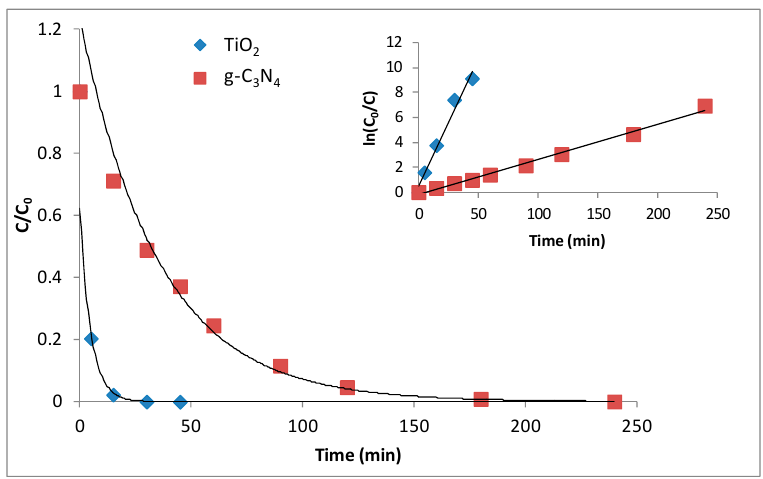
Figure 1. Photocatalytic degradation kinetics of valsartan by TiO 2 and g-C 3 N 4 catalysts ((valsartan) = 5 mg L − 1 ; (catalyst) = 100 mg L − 1 ; I = 500 Wm − 2 ). The concentrations of • OH radicals generated by TiO 2 and g-C 3 N 4 catalysts, as deter- mined by the hydroxy-terephthalic acid fluorescence method (Figure 2), were 22.4 µ M and 0.32 µ M, respectively. The above results are consistent with the catalysts conduction